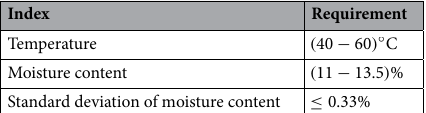
Table 3. Tobacco flakes re-baking index and